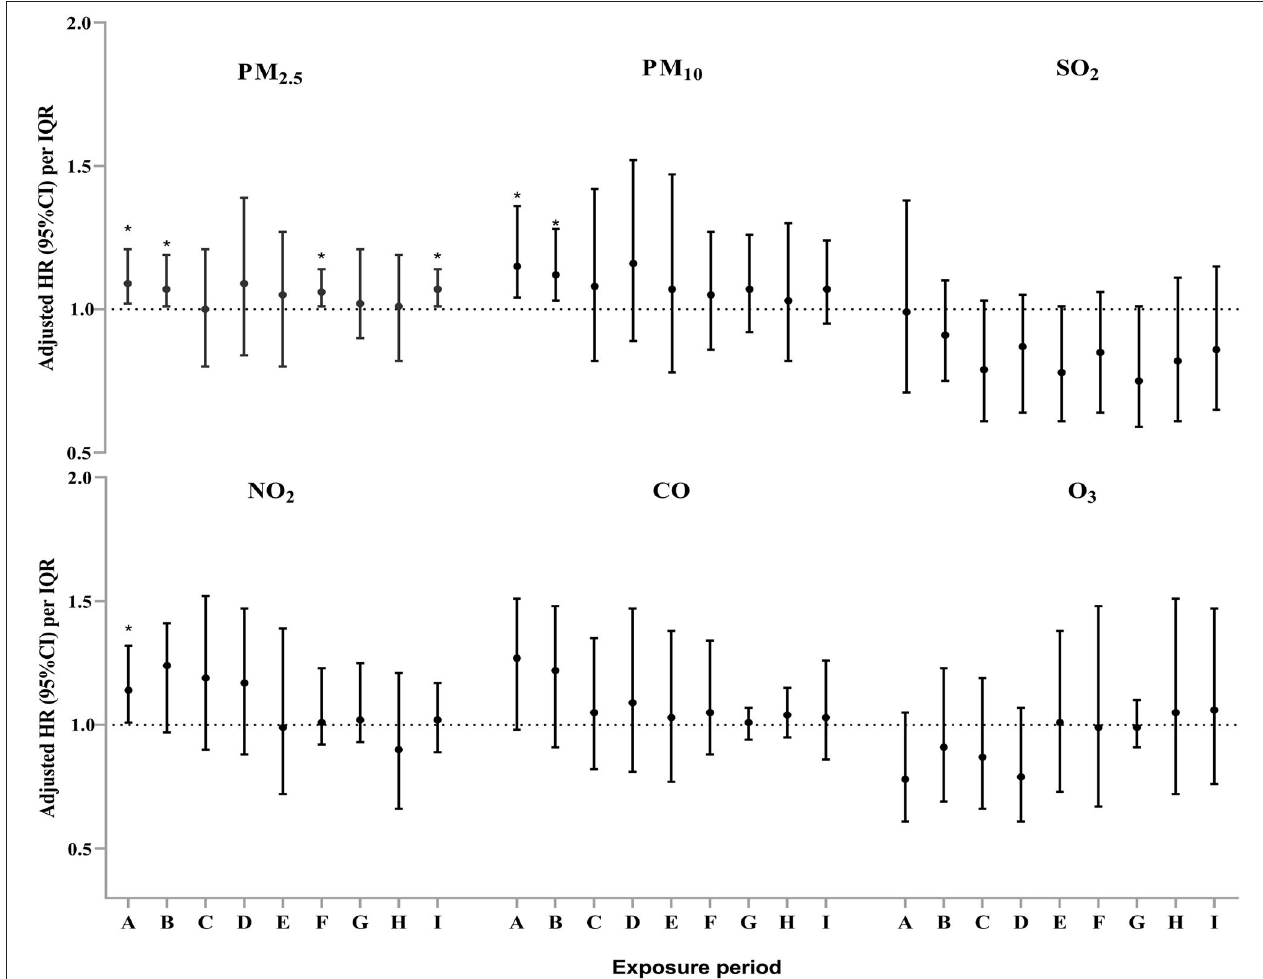
FIGURE 3 | Adjusted hazard ratio (HR) and 95% confidence interval (CI) for the association between exposure to six air pollutants and the incident risk of preterm birth during different exposure periods among the study subjects # . # Model adjusted for maternal age, maternal pre-pregnancy BMI, educational level, employment status, cigarette smoking exposure, residential locations, ambient average temperature, and relative humidity. * P < 0.05.